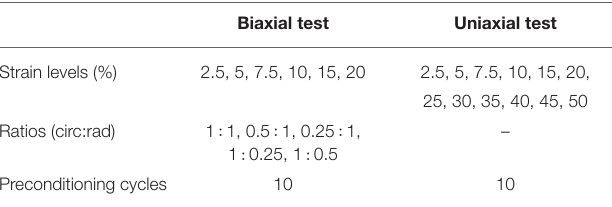
TABLE 2 | Overview of the different strain levels, ratios, and preconditioning cycles in the biaxial and uniaxial test